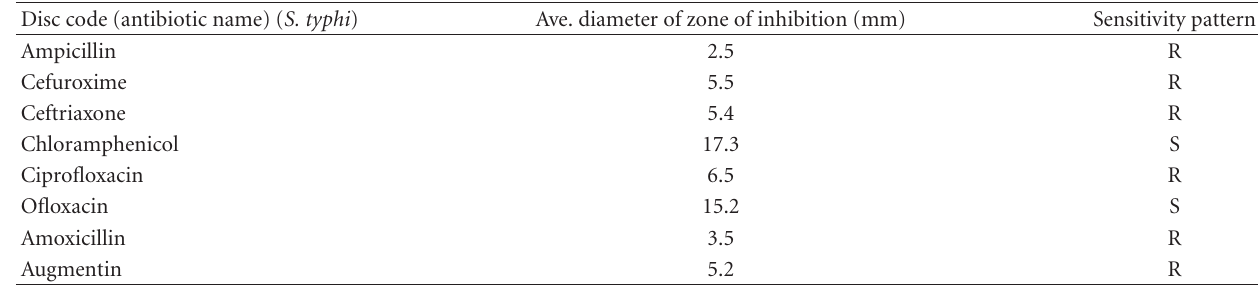
Table 3: Measurement of zone of